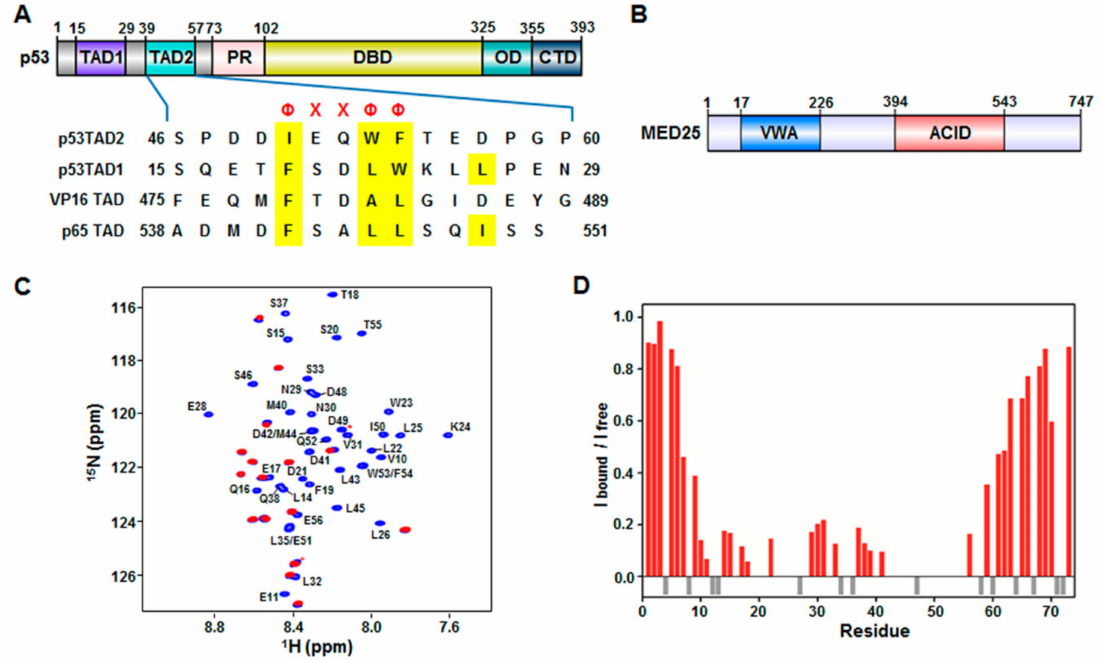
Figure 1. Interaction of mediator complex subunit (MED) 25 activator interaction domain (ACID) with p53TAD. ( A ) Domain organization of p53 and sequence alignment of p53TAD with acidic TADs in VP16 and p65. p53 consists of transactivation domain (TAD), proline-rich domain (PR), DNA-binding domain (DBD), oligomerization domain (OD), and C-terminal domain (CTD). Φ and X indicate a bulky hydrophobic residue and any other residue, respectively; ( B ) Domain organization of MED25. MED25 contains von Willebrand factor A (VWA) domain and activator interaction domain (ACID); ( C ) Overlay of 2D 1 H- 15 N heteronuclear single-quantum correlation (HSQC) spectra of 15 N-labeled p53TAD in the absence (blue) or presence (red) of MED25 ACID at a molar ratio of 1:2. The cross-peaks of 15 N-labeled p53TAD alone (blue) are represented by residues types and sequence numbers; ( D ) Cross-peak intensity ratio (I bound /I free ) for p53TAD (red). Gray negative bars indicate proline